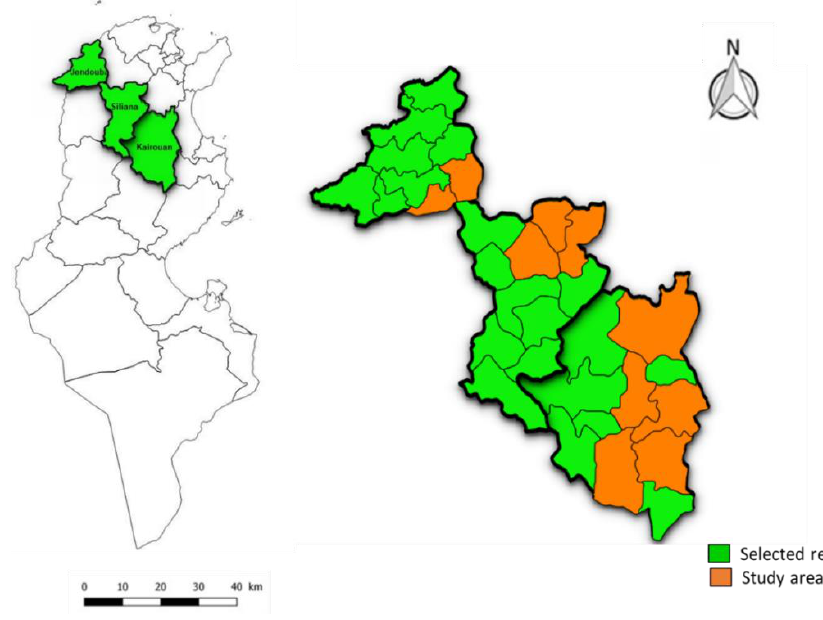
Figure 2. Location of the study